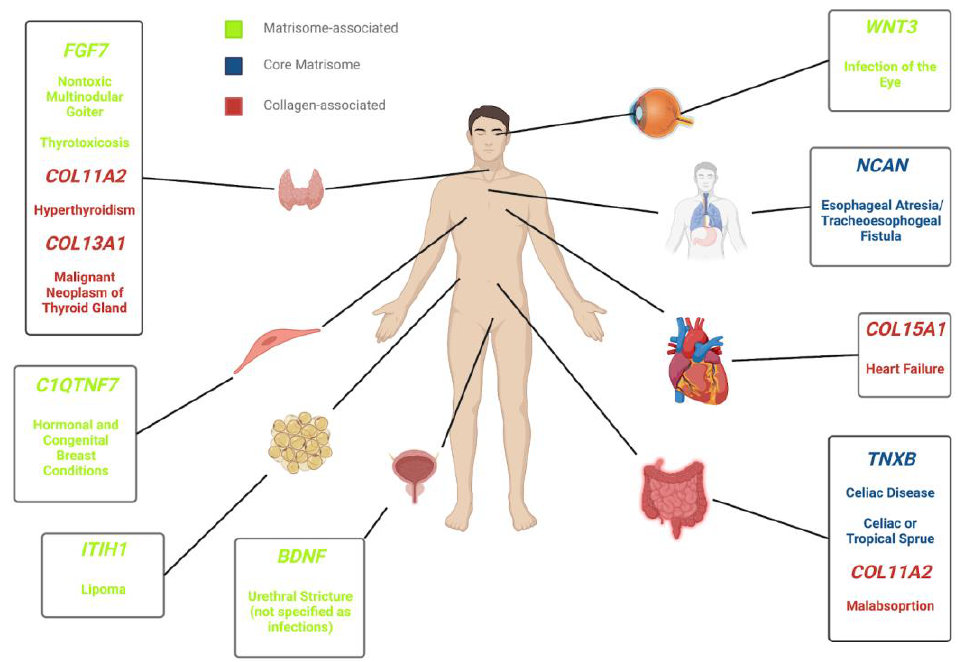
Figure 9. The ECM-Diseasome Body Map. An example of a proposed body map of matrisome genes that are associated with numerous disease states. Certain matrisome genes localize to various tissues in the body and may be linked to more than one disease state, suggesting therapeutic repurposing. This body map can be expanded, and various other body maps can be created through other gene– disease associations, which may be explored in the future.